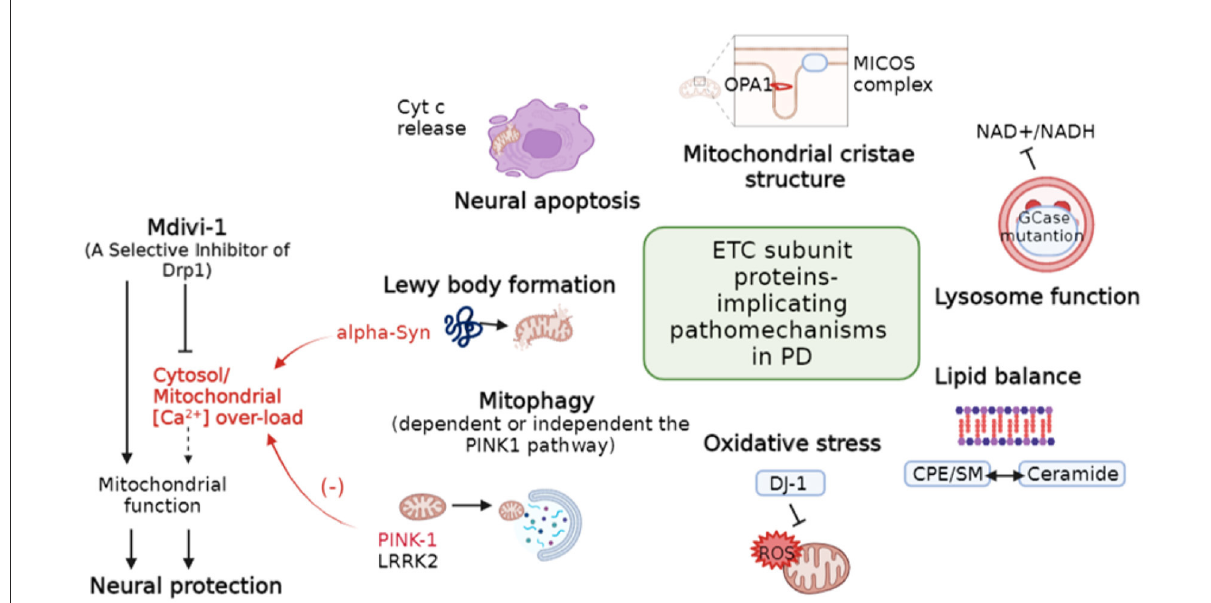
FIGURE1 Diverse regulation of mitochondria-related pathomechanisms in PD. Dotted line indicates hypothetical links. PD, Parkinson’s disease; Cytc, Cytochrome C; MICOS, Mitochondrial contact site and cristae organizing system; CPE, Ceramide phosphoethanolamine; SM, Sphingomyelin. (Modified based on the study: Li et